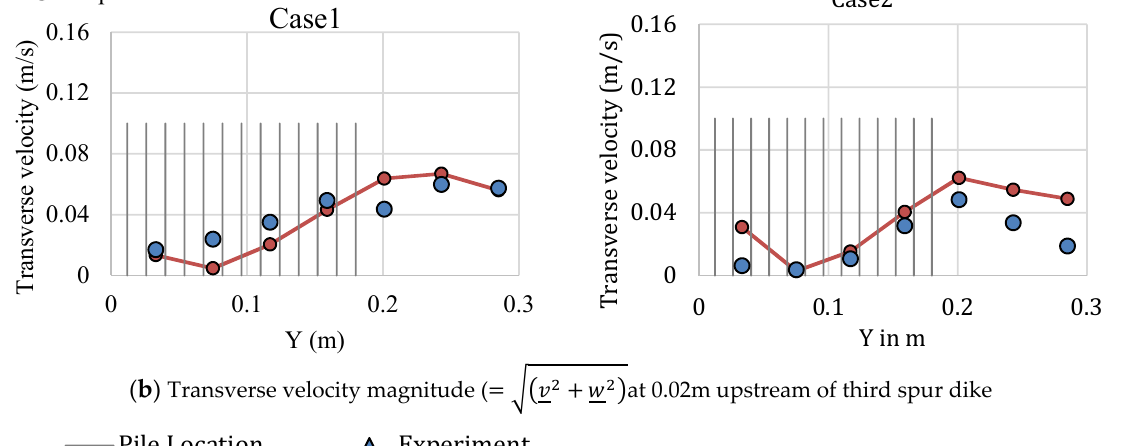
( b ) Transverse velocity magnitude ( = (cid:3495)(cid:3435)𝑣 (cid:2870) + 𝑤 (cid:2870) (cid:3439) at 0.02m upstream of third spur dike